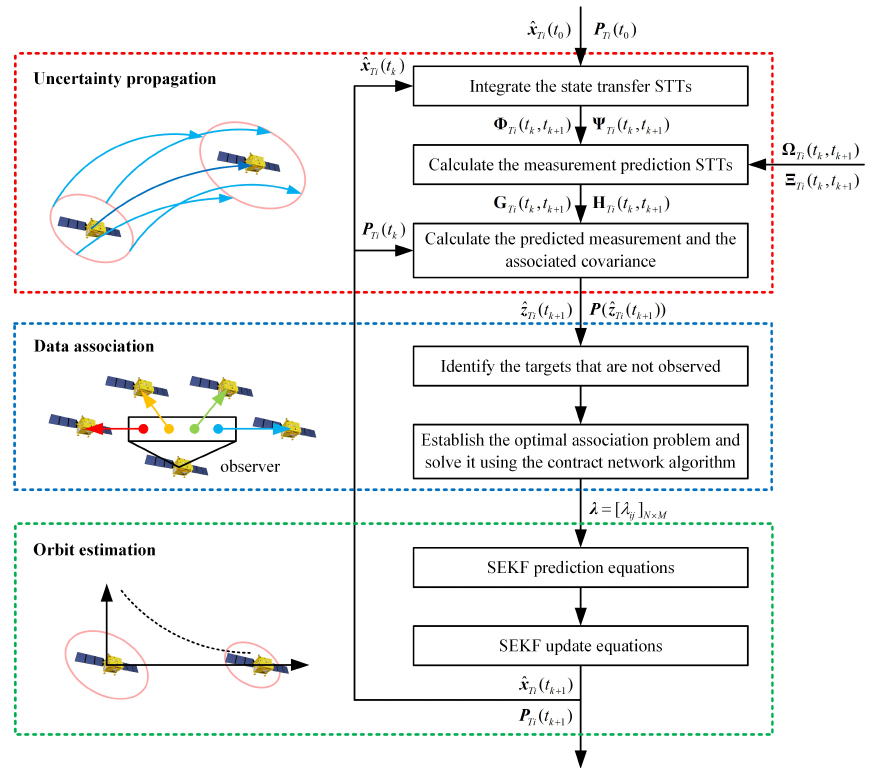
Figure 2. Flow chart of the proposed multi-spacecraft tracking